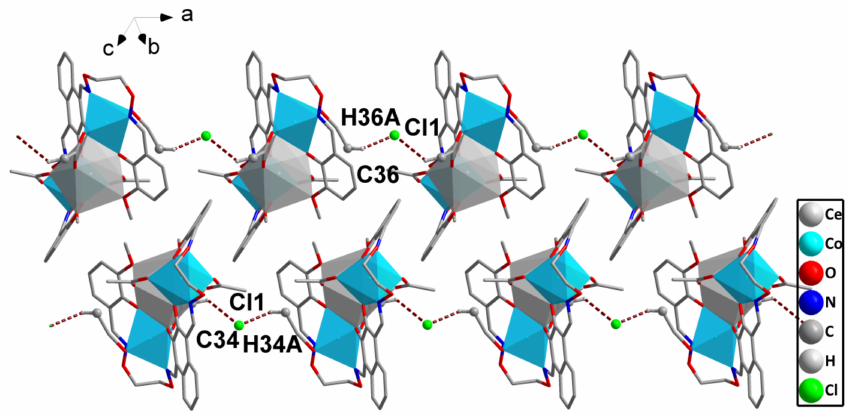
Figure 7. View of 1D supramolecular structure by the intermolecular C–H ··· Cl interactions of the Co(II)-Ce(III) complex.